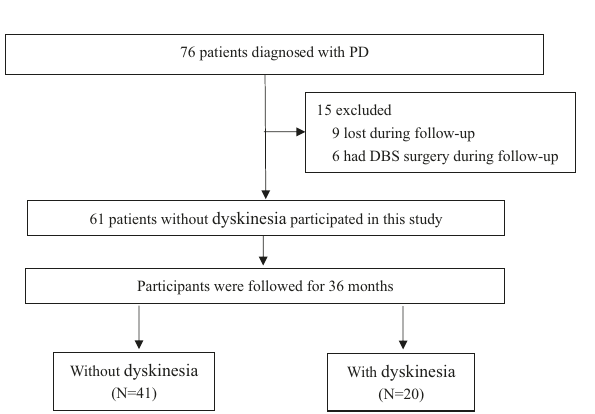
Fig. 6 Flow diagram of the study. DBS deep brain stimulation, PD Parkinson ’ s